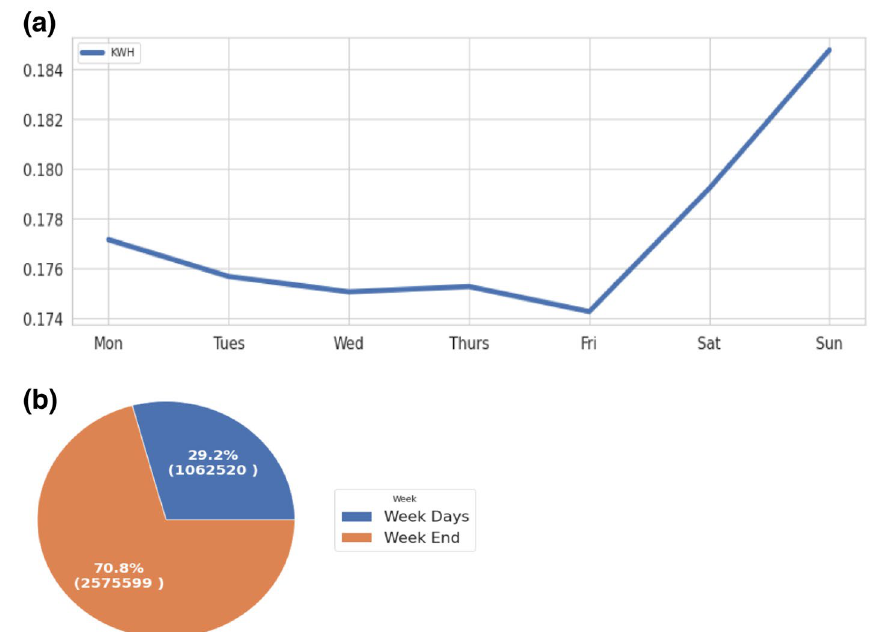
Fig. 13 a Diagram of average weekly consumption. b Diagram of total daily